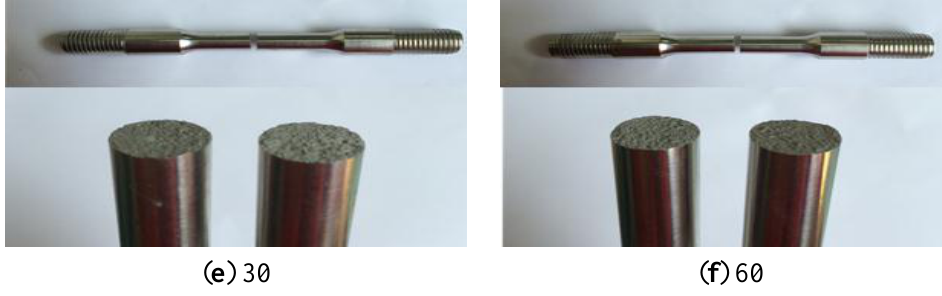
Figure 6. Comparison of fracture surface of SDSS tensile specimens according to various isothermal ageing periods (tested at 20 °C). ( a ) 0 min; ( b ) 5 min; ( c ) 10 min; ( d ) 15 min; ( e ) 30 min; ( f ) 60 min.